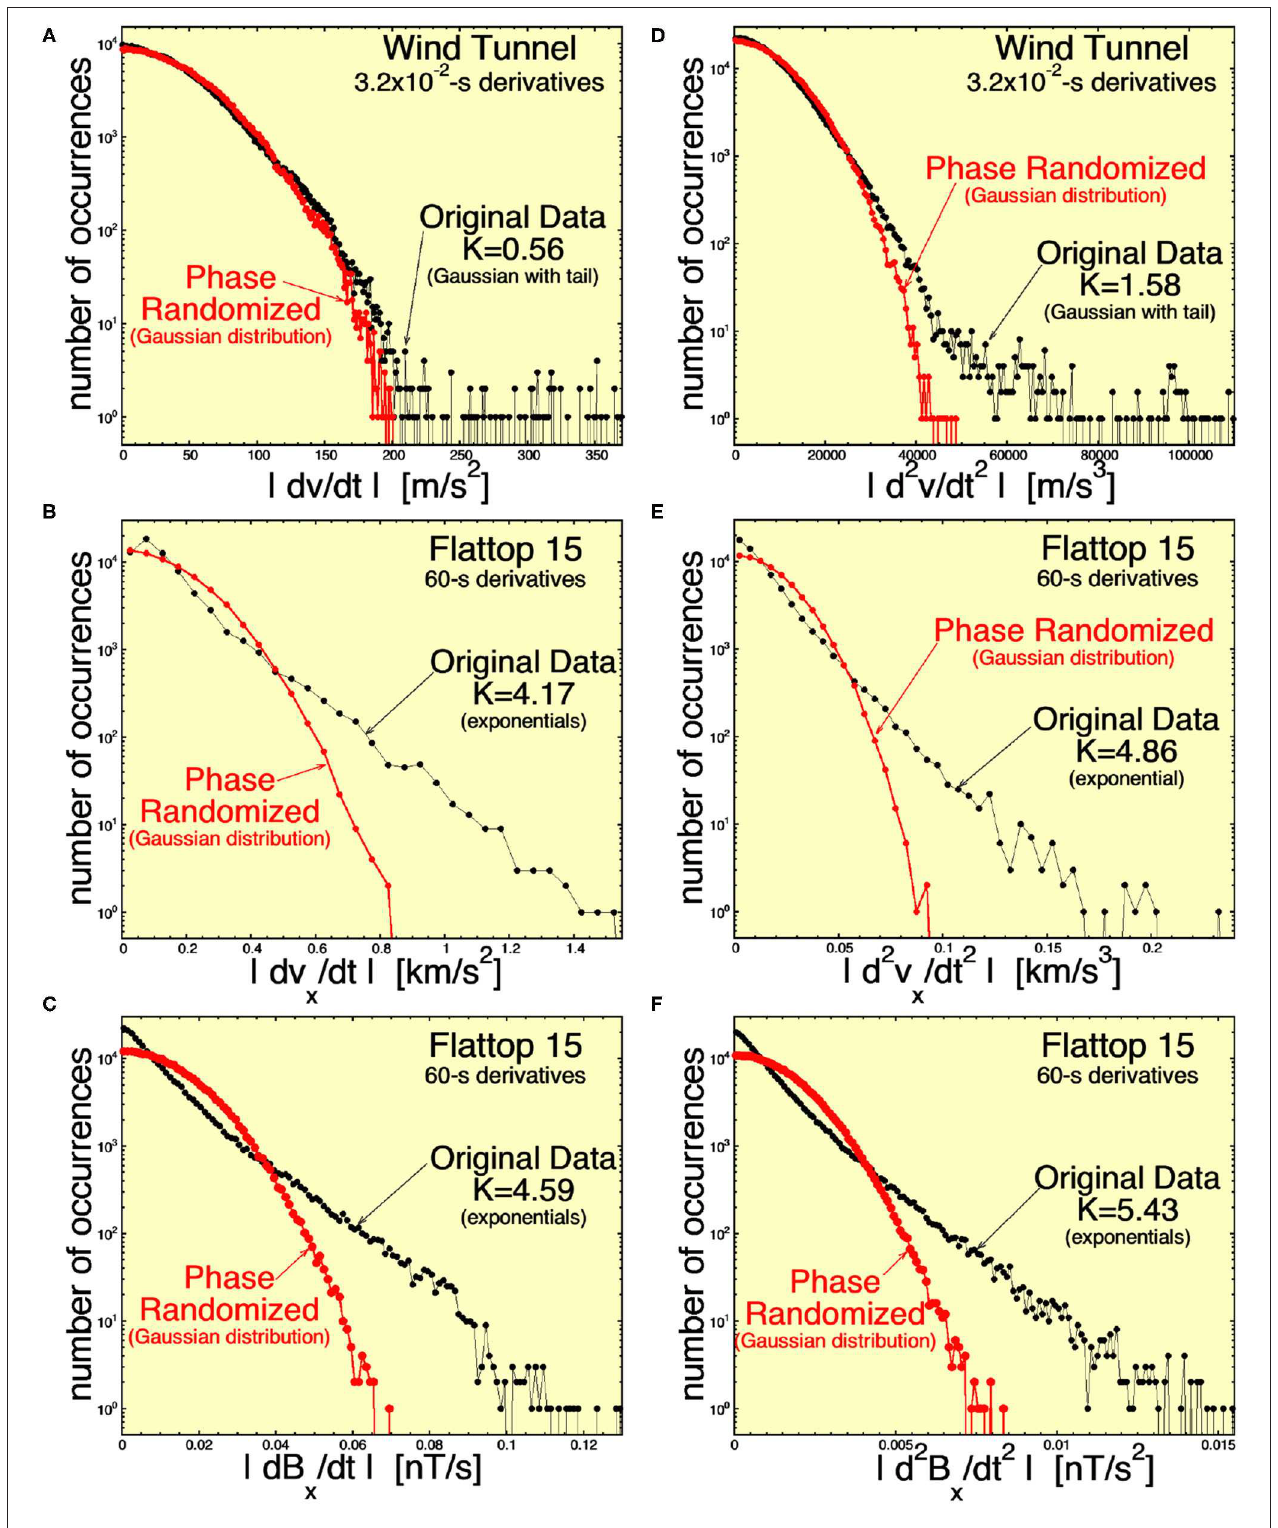
FIGURE 8 | Similar to Figure 6 , distributions of the measured first time derivatives (A–C) and second time derivatives (D–F) for (A,D) the streamwise velocity v in the wind tunnel Navier–Stokes turbulence (B,E) the radial (from the Sun) velocity v x for the Alfvénic solar wind fluctuations of Flattop 15, and (C,F) the radial component of the magnetic field B x for the Alfvénic solar wind fluctuations of Flattop 15. The black curves are time derivatives in the measured time series, and the red curves are time derivatives in phase-normalized versions of the measured time series. Here, time derivatives are over a timescale a factor of 10 longer than in Figure 6 . For the original-data distributions, the kurtosis K of the signed values is